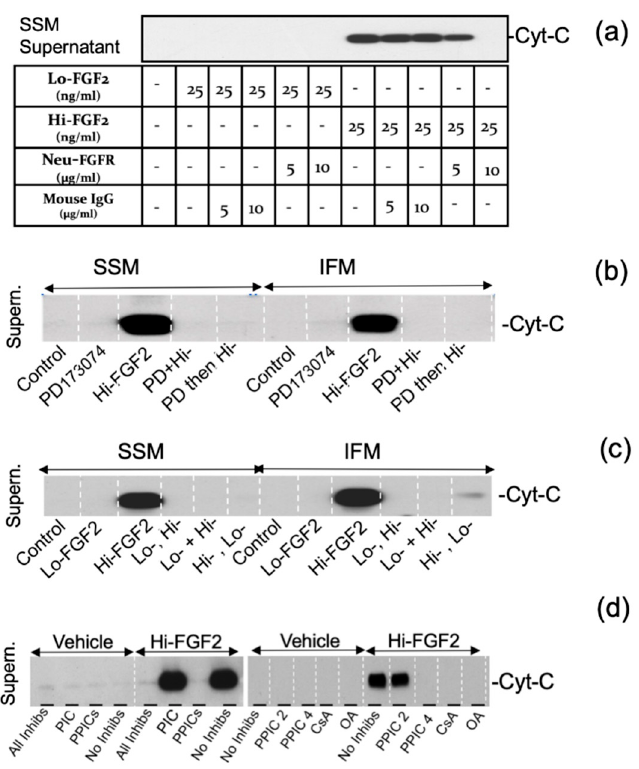
Figure 5. The Hi-FGF2-induced cytochrome c release from cardiac mitochondria is blocked by: FGFR1 neutralization; the FGFR1 inhibitor PD-173074; Lo-FGF2; cyclosporine A; Ser/Thr phosphatase inhibition; ( a ) Western blot showing cytochrome c (Cyt-C) in the supernatant fraction from SSM suspensions, after they were treated with Lo-FGF2 or Hi-FGF2, as indicated, at 25 ng/mL. Neutralizing anti-FGFR1 antibodies, Neu-FGFR, used at 5 or 10 µ g/mL decreased or eliminated, respectively, the Hi-FGF2-induced cytochrome c release. Nonspecific mouse IgG had no effect; ( b ) Western blot showing cytochrome c (Cyt-C) in the supernatant fraction from Hi-FGF2-treated SSM or IFM suspensions. The FGFR1 inhibitor PD-173074 added to SSM or IFM suspensions together with Hi-FGF2, (PD + Hi-), or prior to Hi-FGF2 (PD, Hi-), prevented the Hi-FGF2-induced cytochrome c release, as indicated; ( c ). Western blot showing cytochrome c (Cyt-C) in the supernatant fraction from Hi-FGF2-treated SSM or IFM suspensions. Lo-FGF2 was added to SSM or IFM prior to Hi-FGF2, (Lo, Hi), together with Hi-FGF2, (Lo + Hi), or immediately after Hi-FGF2 (Hi, Lo), and prevented the Hi-FGF2-induced cytochrome c release, as indicated. Both Lo- and Hi-FGF2 were used at 25 ng/mL; ( d ) Western blots of supernatants from SSM suspensions incubated with either vehicle or vehicle + Hi-FGF2, in the presence of various protease and phosphatase inhibitor cocktails and individual inhibitors. Lanes are labelled as follows, from left to right: All Inhibs (mix of protease and phosphatase inhibitors, PIC (protease inhibitors), PPICs (protein phosphatase inhibitors mix), No Inhibs (no inhibitors have been included), PPIC 2 (phosphatase inhibitors set 2), PPIC 4(phosphatase inhibitors set 4), the mPTP inhibitor Cyclosporin A (CsA) at 10 nM, and the PP1 and PP2A inhibitor okadaic acid (OA) at 100 nM.